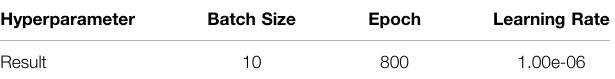
TABLE 5 | Hyperparameter value for train algorithms.